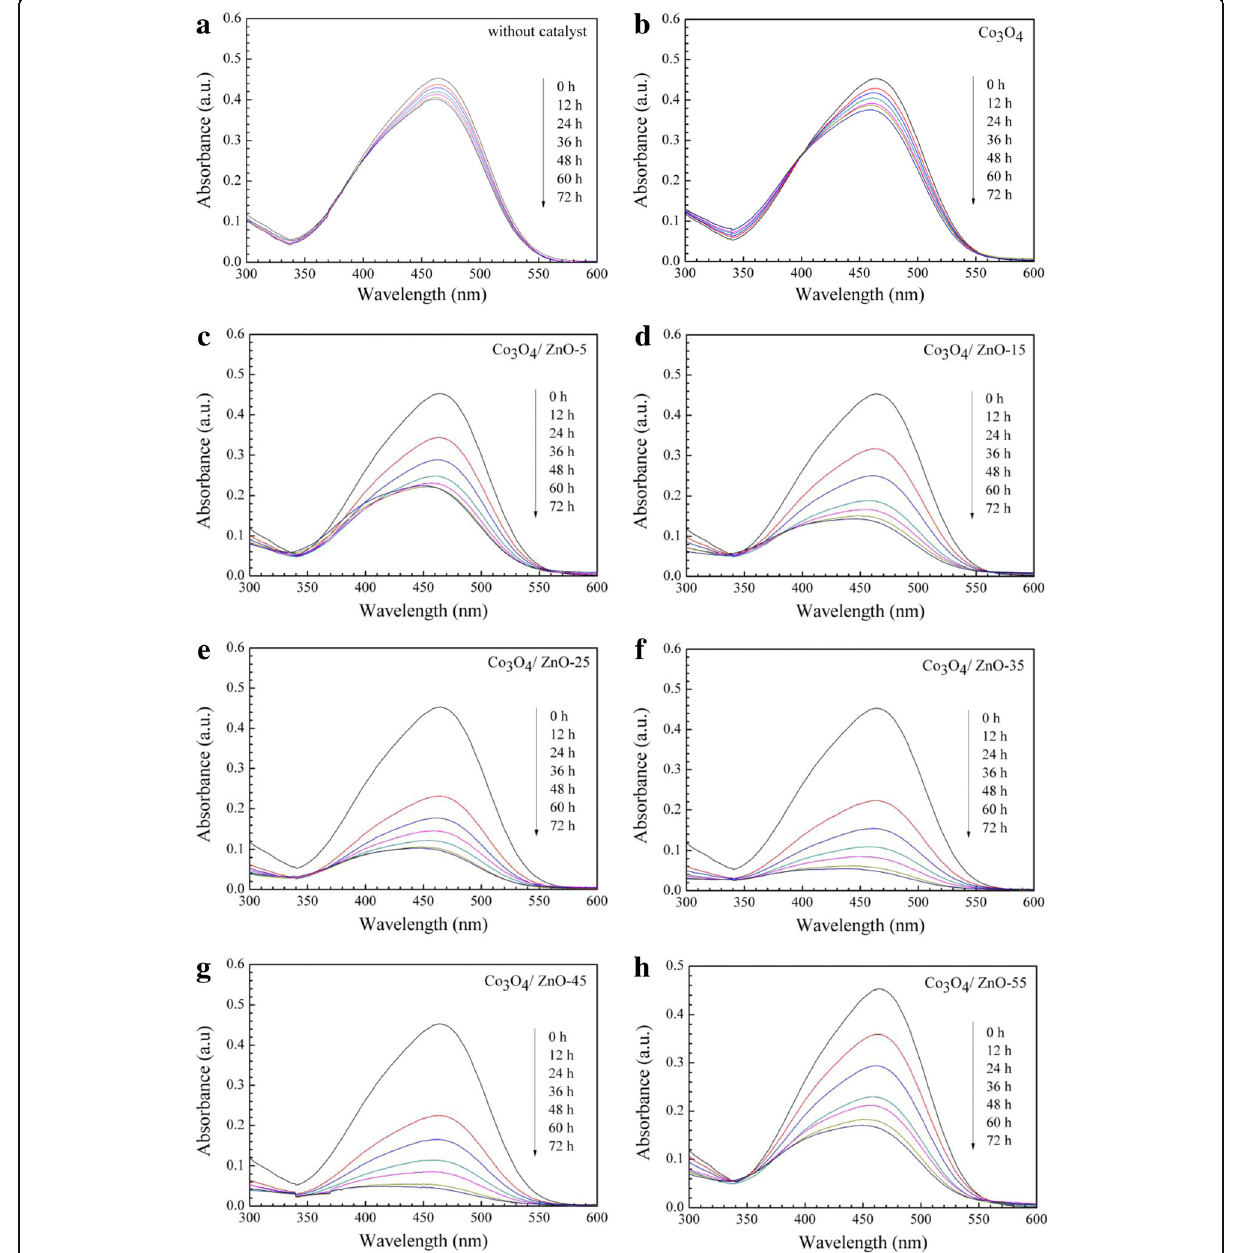
Fig. 10 Irradiation time-dependent UV-vis absorbance spectra of MO aqueous solution: a without catalyst, and in the presence of b pure Co 3 O 4 , c